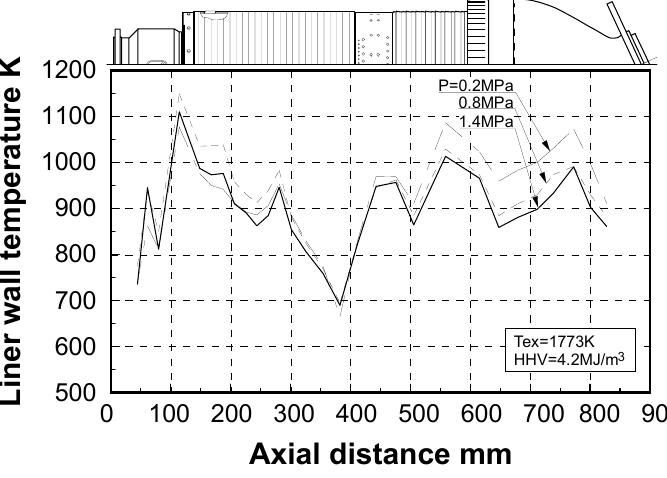
Figure 64. Influence of combustion pressure on combustor wall temperature